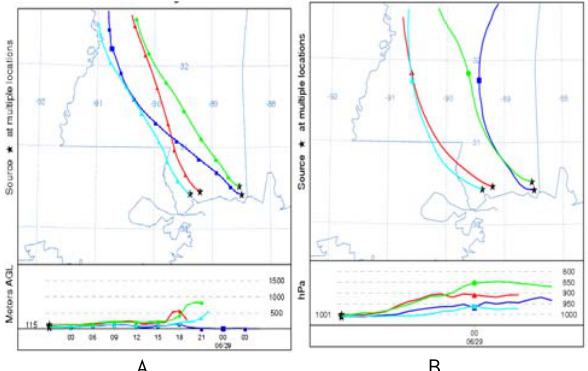
Figure 16: Forward trajectories of the particles starting at 00 UTC (a) and at 12 UTC (b) on 28 June from the four emission sources [Green – Gulfport (height of release– 115 m); Red – Gulfport (height of release - 45 m); Cyan – Pascagoula (height of release 54 m); Blue – Pascagoula (height of release 45 m)] Vertical cross-sections of integrated particle positions in the direction of the plume are shown in Fig. 17. They represent the vertical dispersion of the particles at different times during the day. In the night conditions, stable thermal stratification prevails and the particle vertical mixing is limited to the lower 0.5 km region. The deep plume in the night condition shows the particles advected earlier during the day time. During the daytime the boundary layer grows vertically and there is enhanced mixing and vertical spread of the particles as noted from Fig.17a. Particles are densely distributed within a layer of about 200 m above ground level, especially during the late night associated with stable conditions.